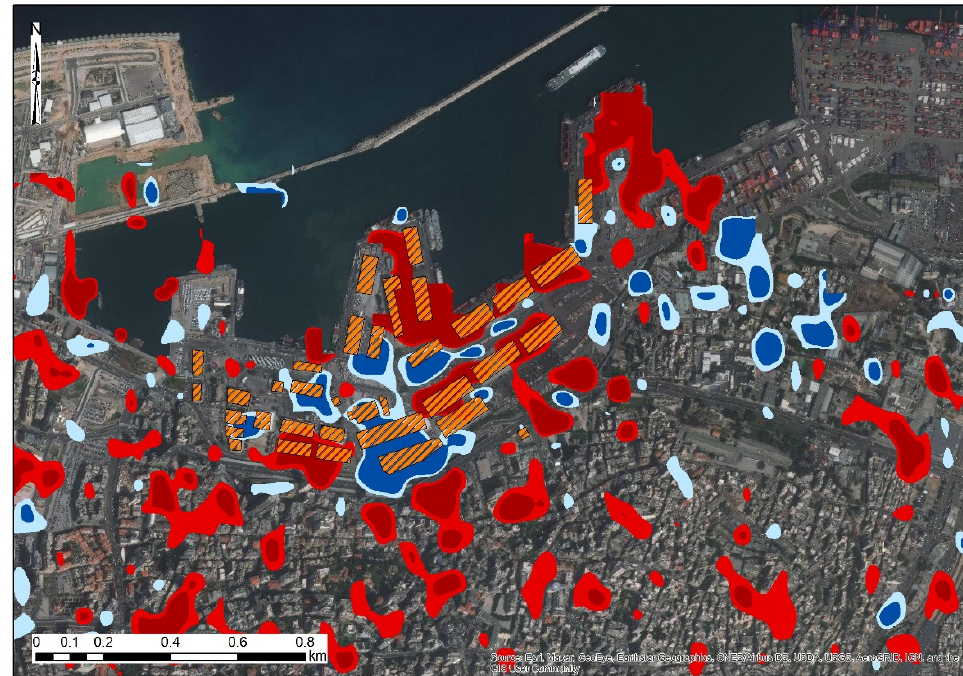
Figure 12. Change detection results as generated from the VV and VH log di ff erences of the Sentinel-1 images around the blast site, while orange polygons indicate the buildings that have been damaged as reported by the MapAction platform [21] (digitized by the author).